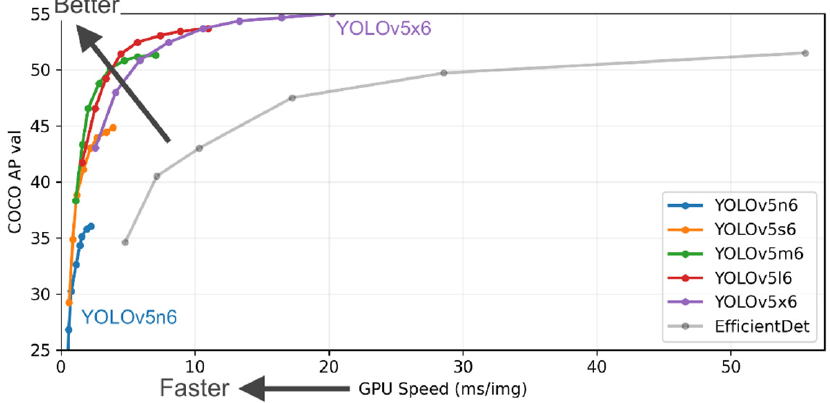
Figure 4. YOLOv5 performance metrics (Reprinted from ref. [13]).